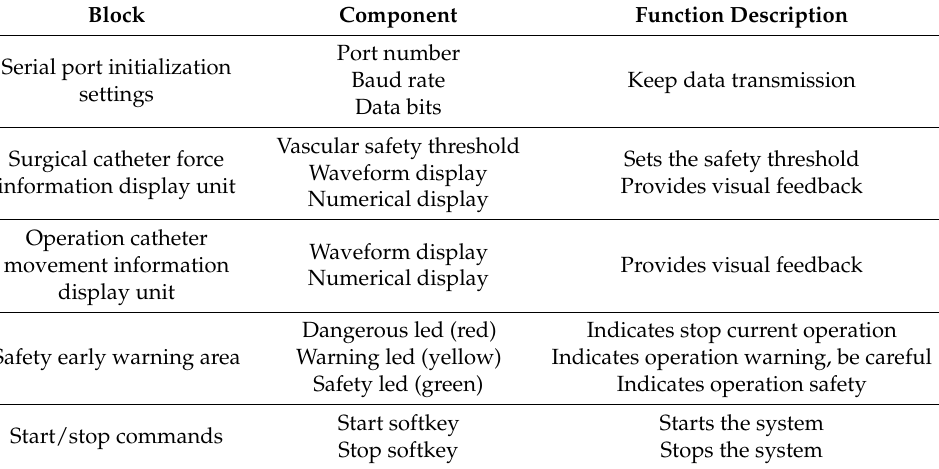
Table 1. Description of the operation safety early warning system functionalities.